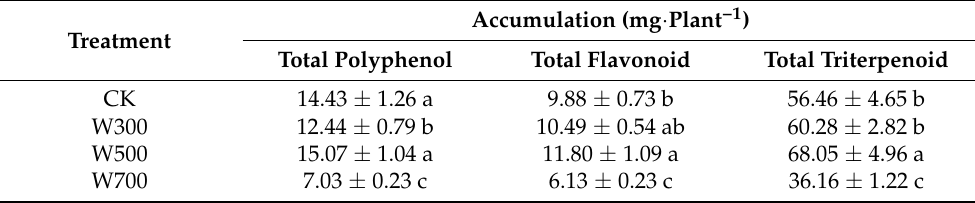
Table 4. Effects of wheel wingnut-based biochar pyrolyzed at different temperatures on secondary metabolite accumulations in C. paliurus leaves.